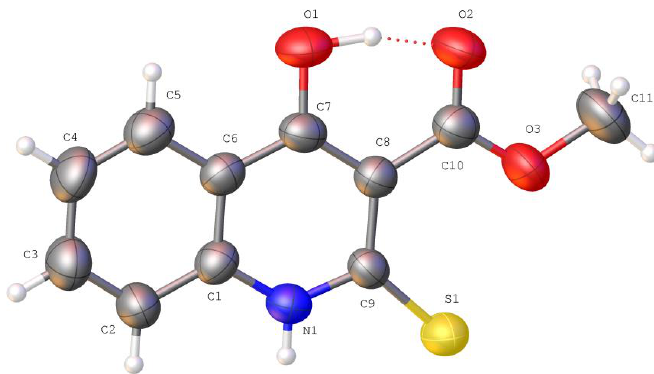
Figure 1. Molecular structure of compound 13 according to X-ray diffraction data. Thermal displacement ellipsoids are shown at the 50% probability level.